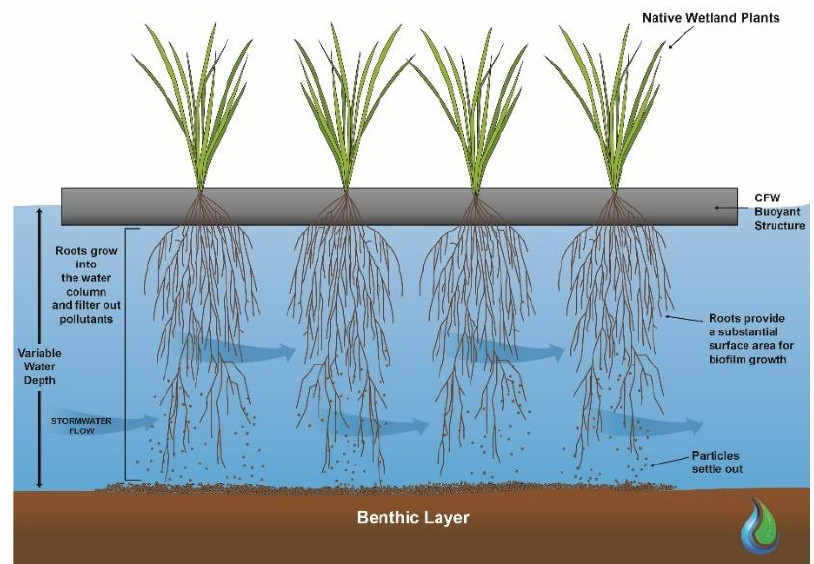
Figure 1. Schematic of Constructed Floating Wetland.